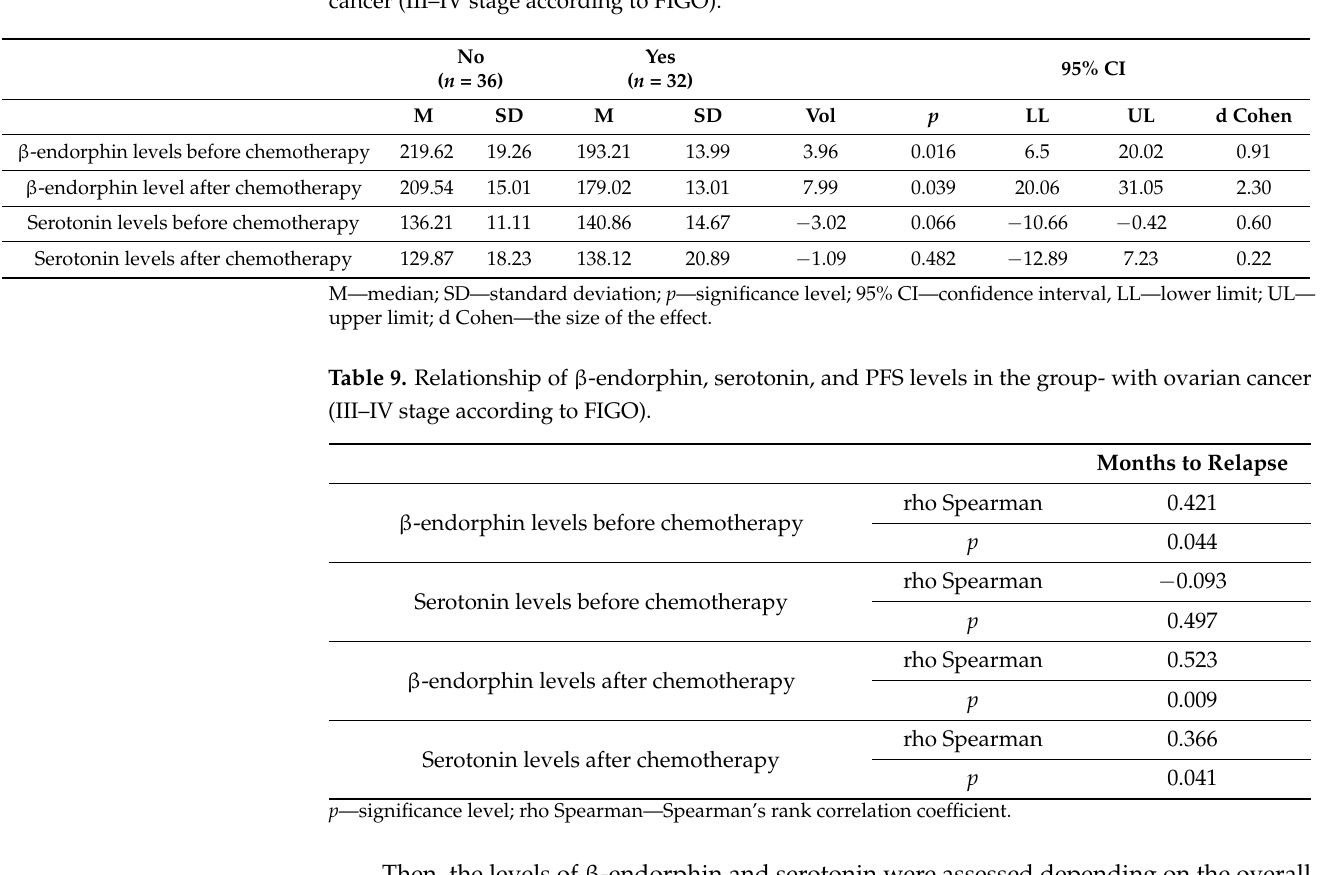
Table 8. The level of β -endorphin and serotonin and the recurrence in the study group with ovarian cancer (III–IV stage according to FIGO).